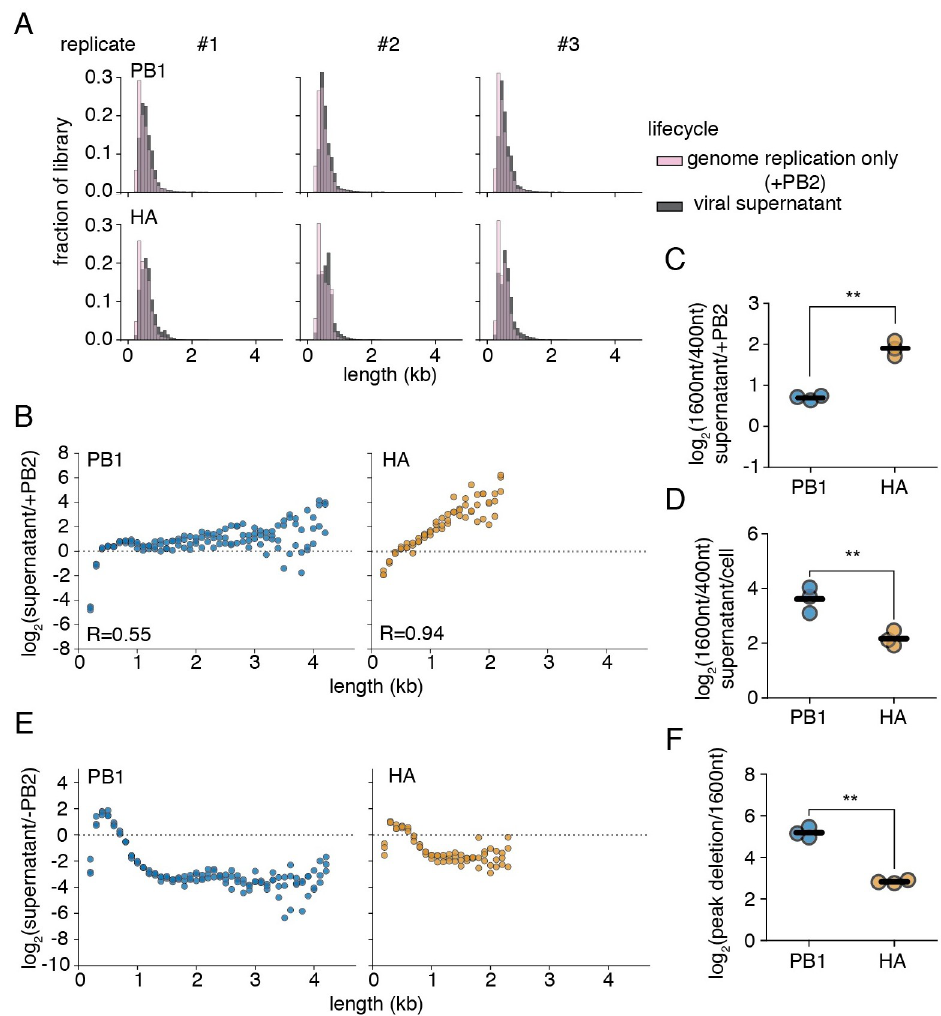
Fig 3. PB1 and HA variants exhibit divergent dynamics during population expansion. (A) Variant distribution after replication alone (+PB2), or in the supernatant after 72h of infection with wild-type, virus. (B) Association of length versus enrichment in the supernatant for PB1 and HA. The fraction of variants falling within each 100nt bin was compared between replication only and supernatant selections. Lengths above the dotted line are enriched during viral expansion. Points were only shown if represented in all three libraries under both conditions R is the Spearman correlation coefficient. n = 3. (C) qPCR confirmation of data from (B) . The ratio of a 1600nt to a 400nt product was compared between replication only and supernatant samples as in (B) . n = 3 (D) Packaging excludes smaller variants from the population. Experiments performed as in Fig 2D, with supernatant harvested and compared to the cell fraction at 14 hours. n = 3. (E) Conflicting pressures during population expansion shape the distribution of defective particles. The fraction of variants falling within each 100nt bin was compared between polymerase I (-PB2), and viral supernatant. Data plotted as in (B) n = 3. Size distributions for each state shown in S4 Fig. Correlation between replicates shown in S5 Fig (F) Enrichment for smaller PB1 variants was stronger than for HA variants in (E) . Maximally-enriched size bin for each library replicate was compared to matched values at 1600nt. n = 3. For panels (C) , (D) , and (F) , each point represents a single measurement, lines represent means. All measurements significantly differed from no enrichment of the measured species by one-tailed t-test, with Benjamini-Hochberg corrected FDR < 0.05 within each panel. Significant differences between HA and PB1 noted with asterisks, p < 0.05, two-sample t-test.